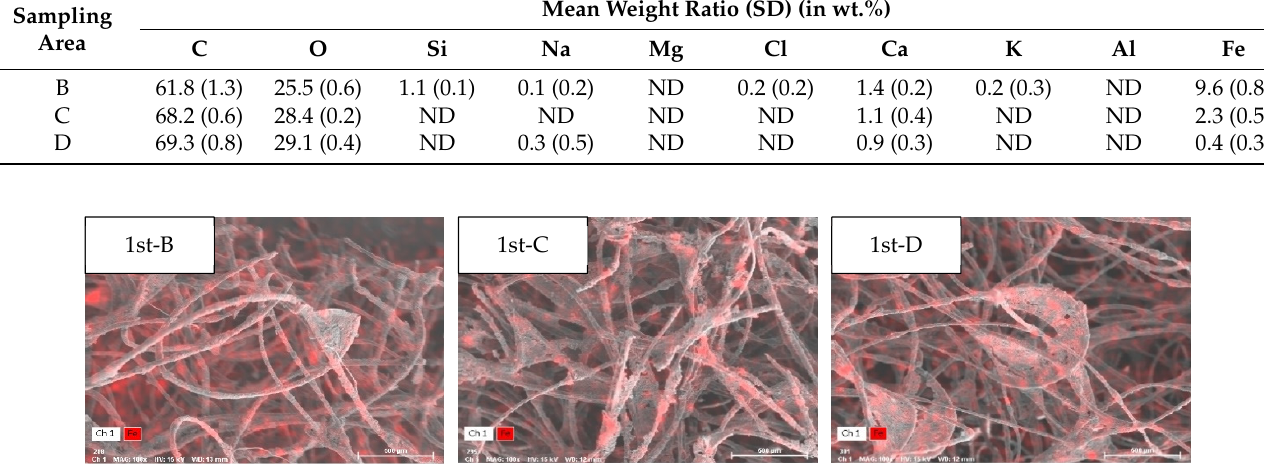
Table 6. Weight ratio for each major element of the return air, using SEM-EDS, on 28 June. Sampling Area